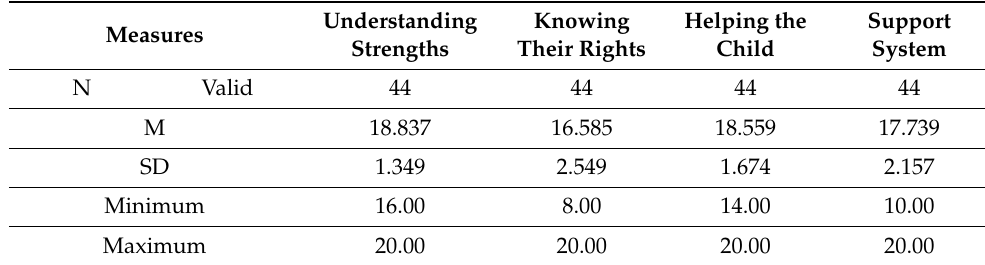
Table 2. Perceived family empowerment.